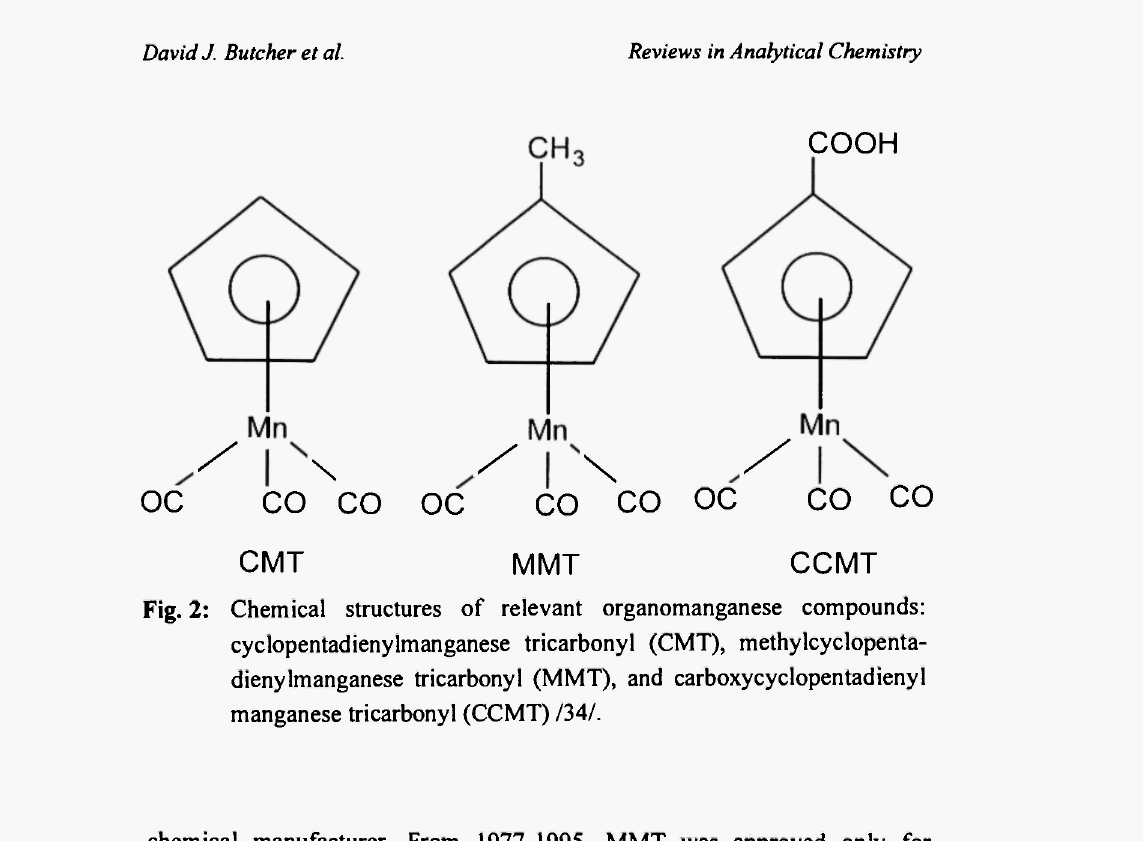
Fig. 2: Chemical structures of relevant organomanganese compounds: cyclopentadienylmanganese tricarbonyl (CMT), methylcyclopenta- dienylmanganese tricarbonyl (MMT), and carboxycyclopentadienyl manganese tricarbonyl (CCMT)